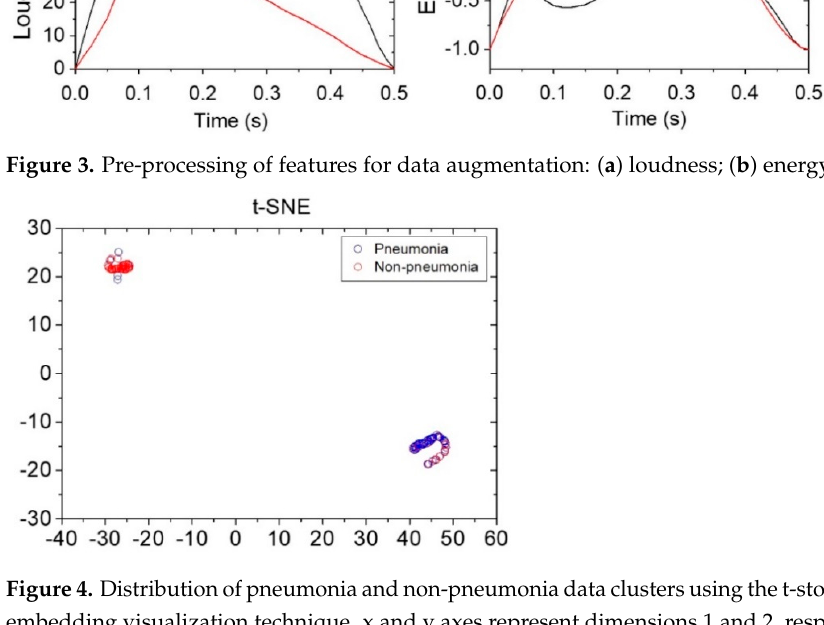
Table 3. Comparison of pneumonia diagnostic results between artificial intelligence ‐ based algo ‐ rithm and pulmonologists using cough sounds.